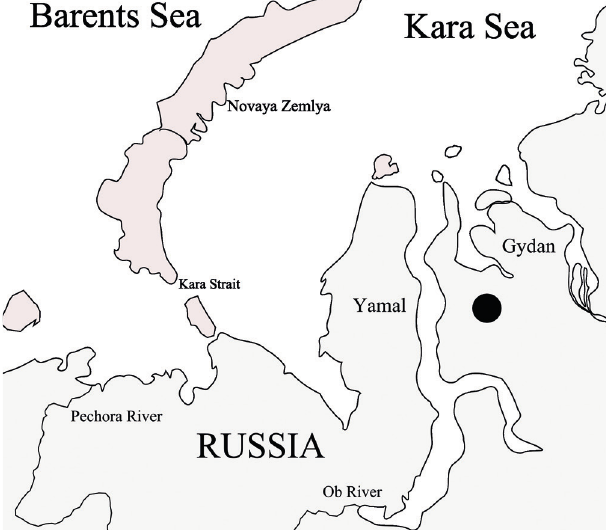
Figure 1. Collection site of Ch. heteropilicornis in Gydan Peninsula, Russia. The collection site is marked by a black